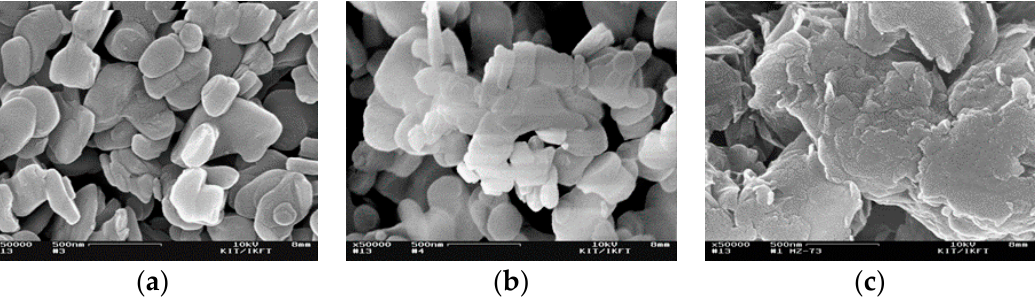
Figure 7. SEM images of the catalyst hydrotalcite in 50,000× ( a ) before calcination, ( b ) calcinated and ( c ) after isomerization; reaction conditions: T = 100 °C, t = 40 min, pH = 2, air atmosphere, m catalyst /m glucose = 0.2.